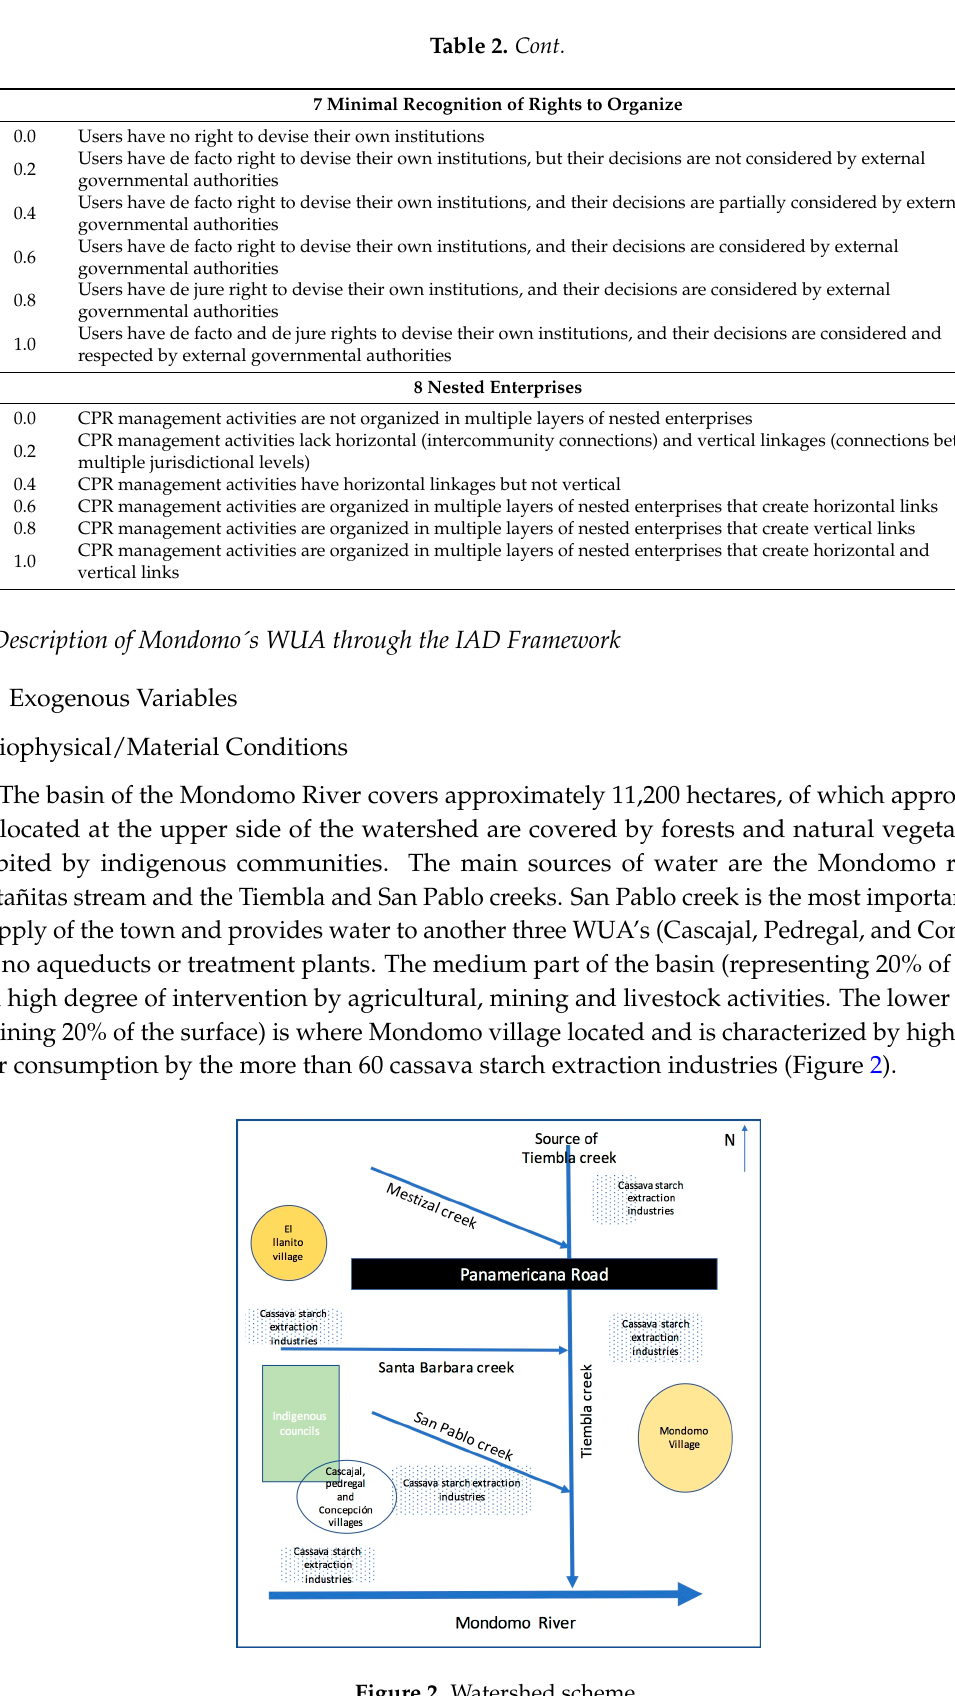
Figure 2. Watershed scheme.